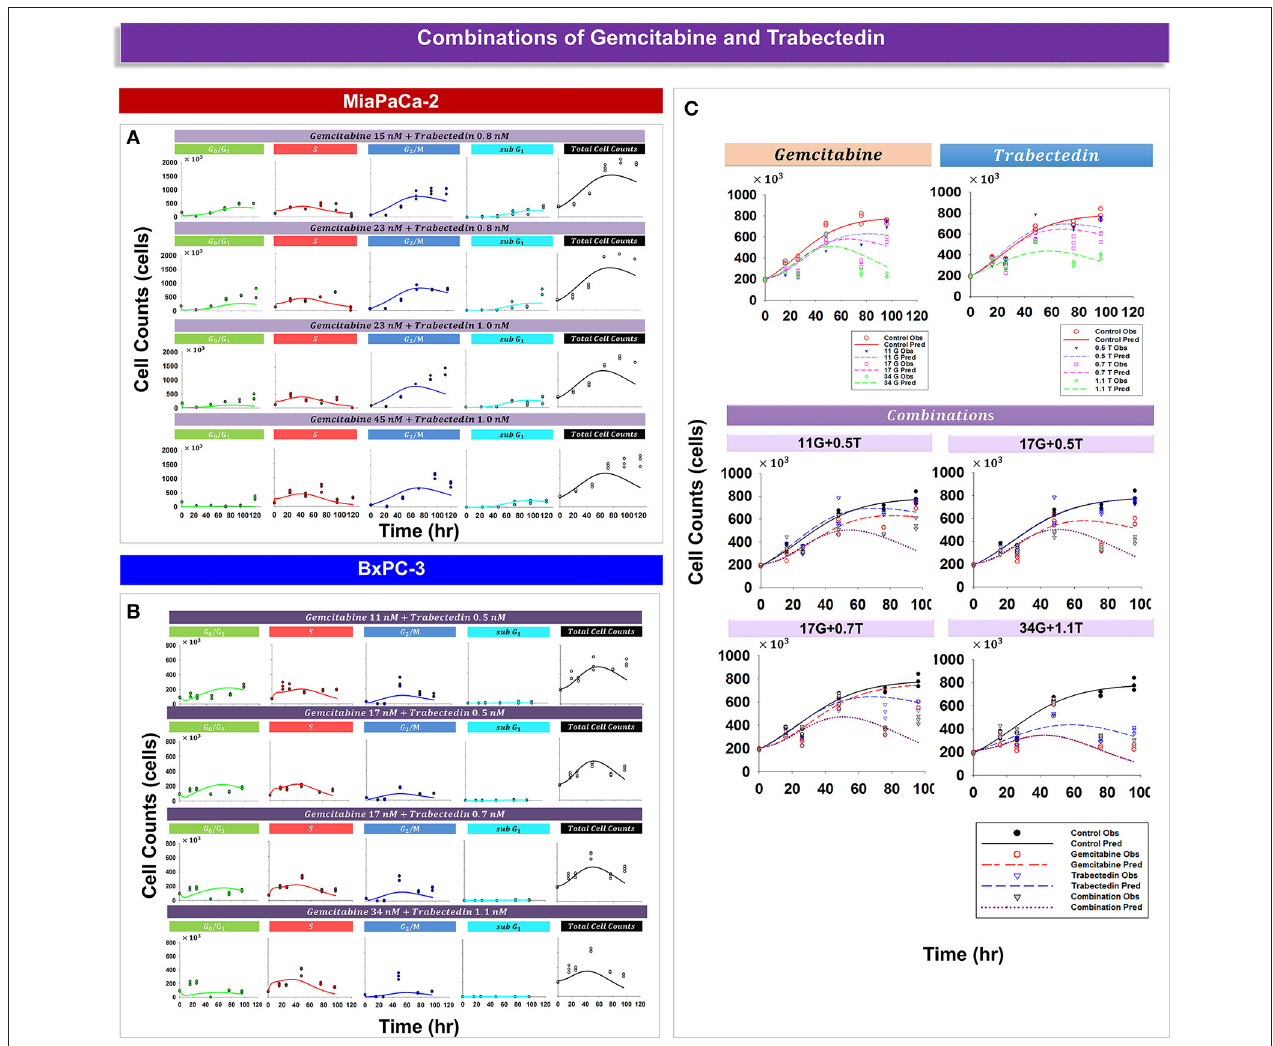
FIGURE 5 | Drug combination effects and model-fittings based on individual drug mechanisms for MiaPaCa-2 and BxPC-3 cells. (A,B) Observed data and model fitting results for cells exposed to different combinations of drug concentrations. Symbols represent cell numbers in G 0 / G 1 , S , G 2 / M , and sub G 1 phases; lines depict model fittings to the PD model shown in Figures 1F,G . (C) Shown are temporal cell proliferation profiles and model fitting results for single drug effects and four different drug combinations for total BxPC-3 cells. Symbols represent experimental data and lines indicate the corresponding model